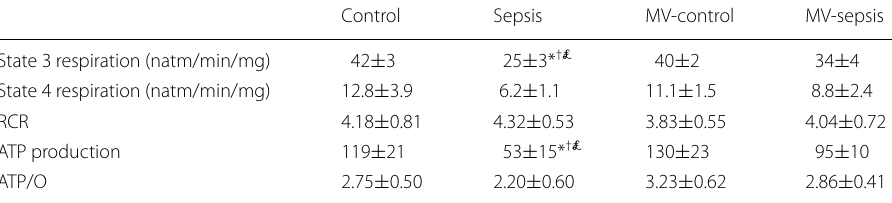
Measures were performed on diaphragm mitochondria from rats of the four following groups: spontaneously breathing controls (Control), spontaneously breathing sepsis group (Sepsis), mechanically ventilated control group (MV-control) and